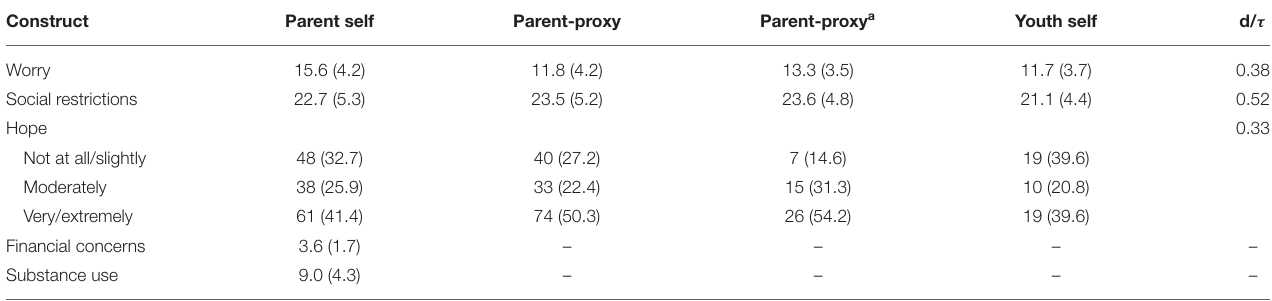
TABLE 3 | Psychosocial health related to COVID-19 [Coronavirus Health Impact Survey